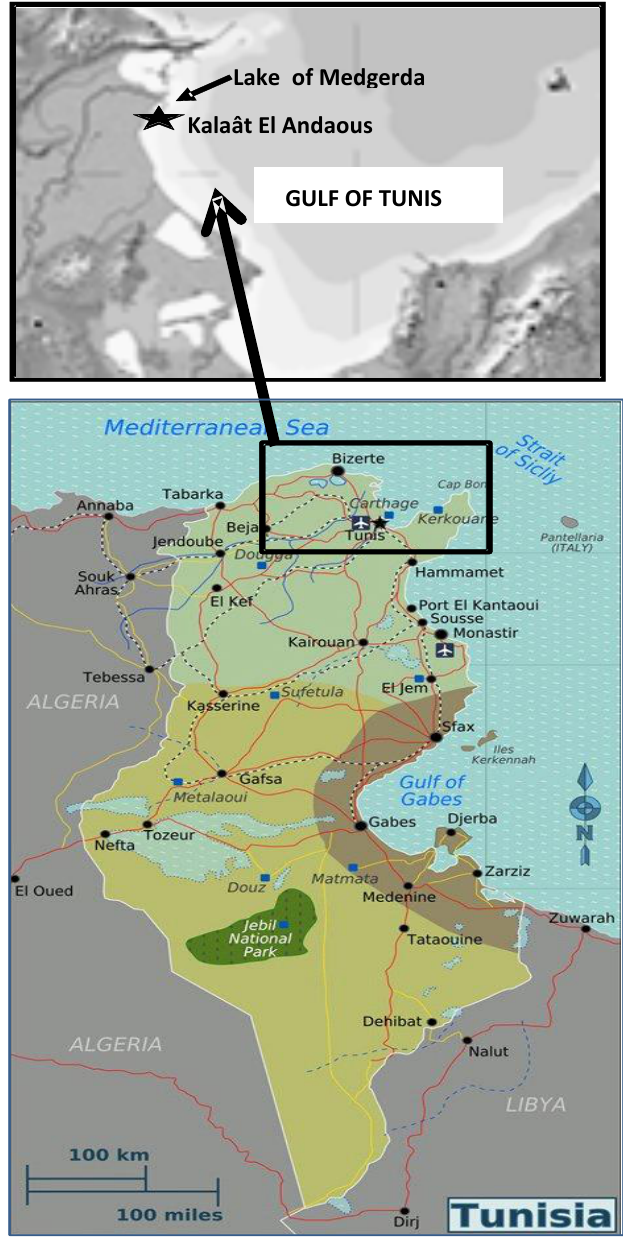
Figure 1. Maps of sampling area in Tunisia (The black full star in the Gulf of Tunis shows the sampling site: Kalaât El